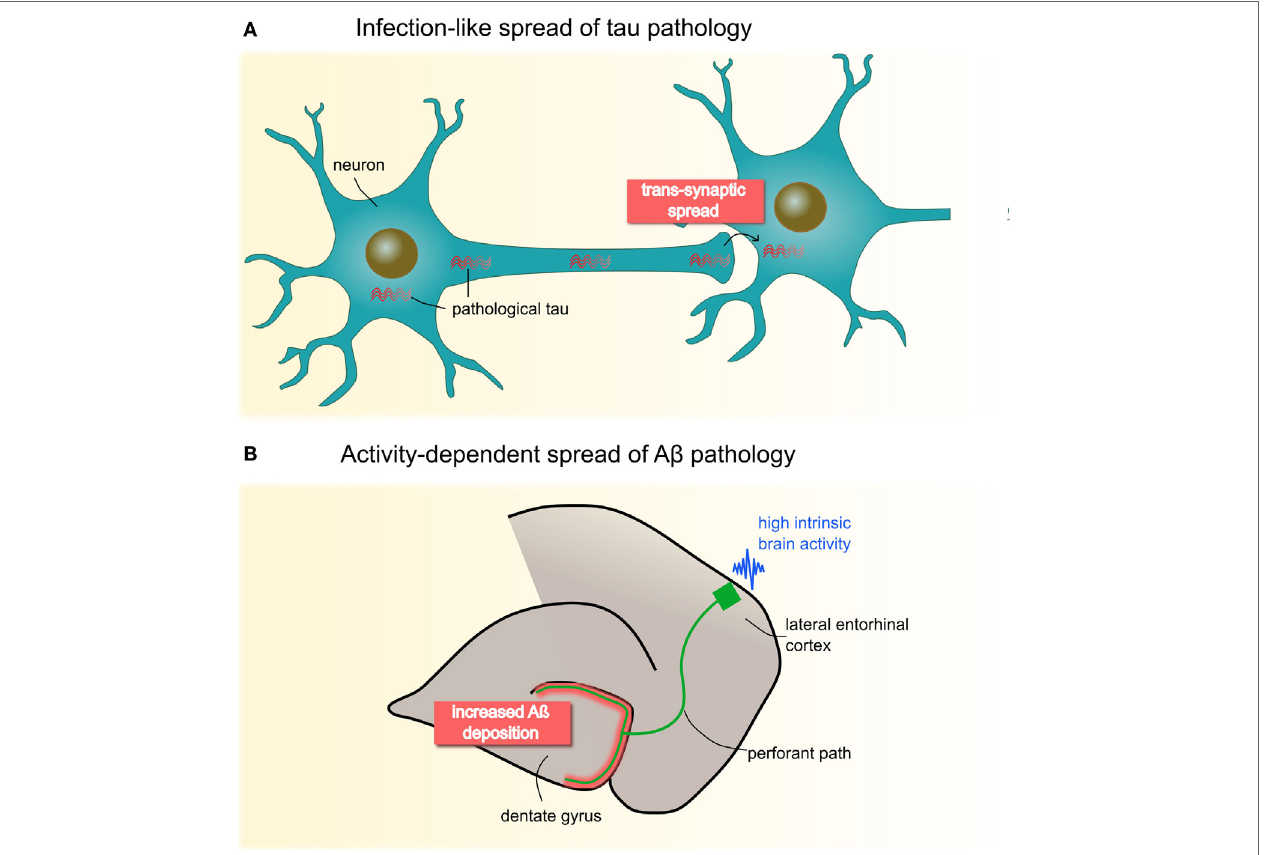
FigUre 1 | Animal studies have proposed two molecular mechanisms of neuropathological spread in Alzheimer’s disease (A) Pathological tau seems to propagate in an infectious- or prion-like mode: fibrillary protein seeds travel through the axon and across synapses to healthy cells, where they induce template-directed misfolding and aggregation of, until then, naïve proteins. Seminal work by Clavaguera et al. (8) shows that injections of brain extracts from a transgenic mouse line expressing mutant human tau induces misfolding of endogenous tau in recipient mice. Notably, over time, tau aggregates were found beyond the injection site in remote brain areas pointing to a self-propagating, trans-synaptic spread mechanism. (B) Deposition of A β has been shown to occur in an activity-dependent manner, such that chronic synaptic hyperactivity, e.g., in highly connected brain regions, is causally related to A β burden. This has been convincingly demonstrated by Yamamoto et al. (12) who applied chronic optogenetic activation of the hippocampal perforant pathway in a transgenic mice line expressing the amyloid β precursor protein. Their data revealed that optic stimulation of the lateral entorhinal cortex over 5 months heightens A β deposition specifically in presynaptic projection areas (i.e., dental gyrus), possibly though induced hyperactivity. Panel (B) is modified from Yamamoto et al. (12), open access article under the CC BY license (http://creativecommons.org/licenses/by/4.0/).